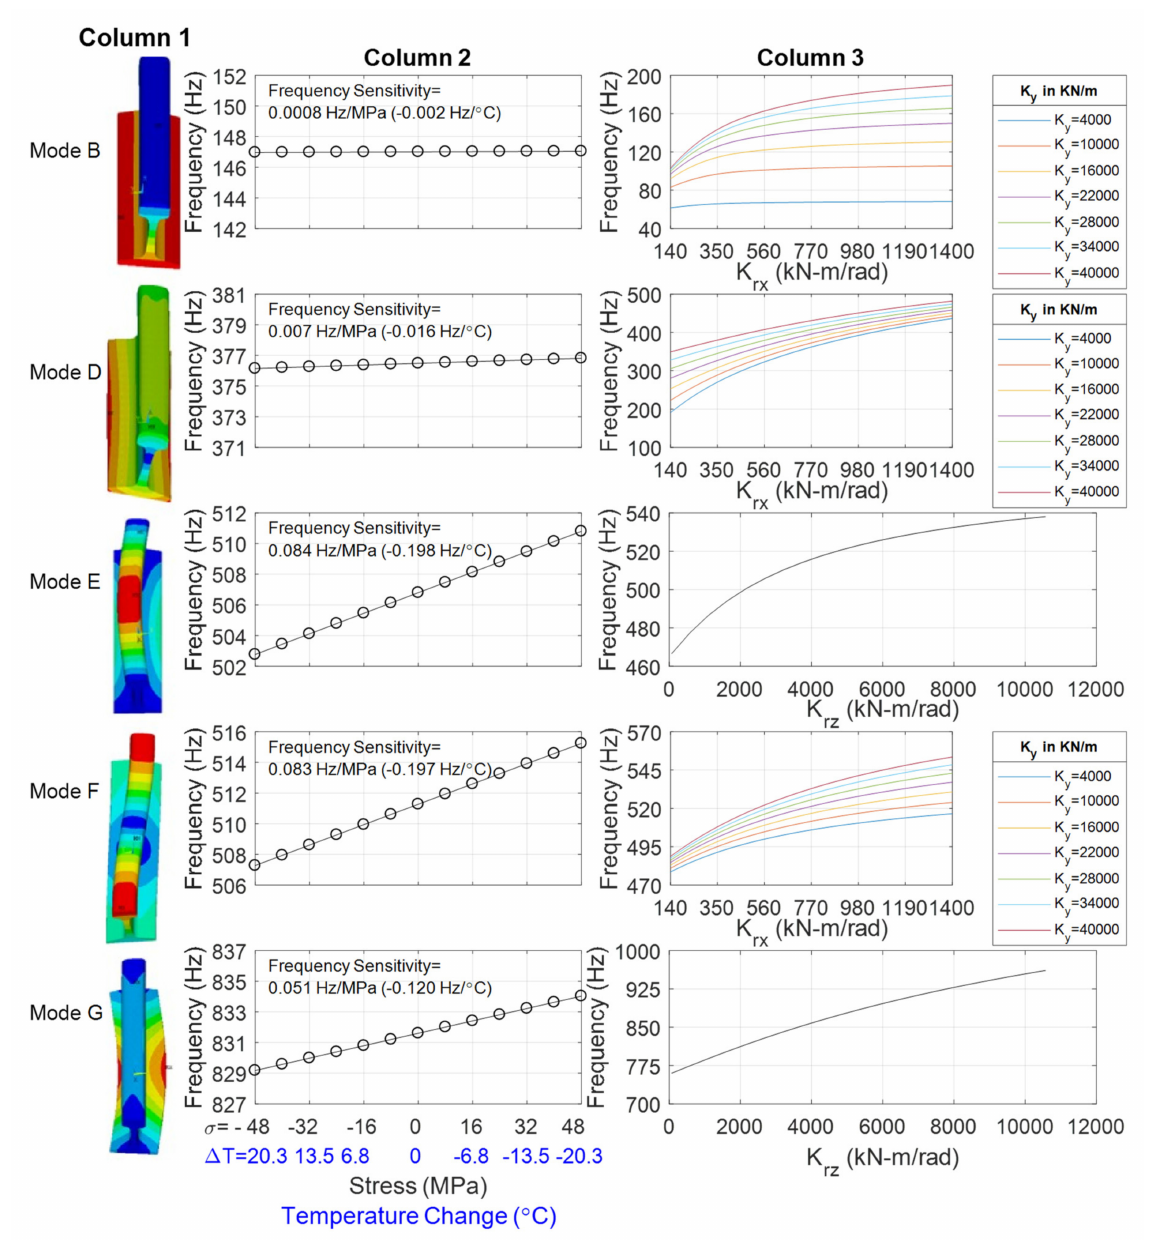
Figure 4. Finite element modeling of a RE 141 tangent track on concrete ties. Left column: mode shape of the lowest five modes. Center column: frequency as a function of stress and temperature change (with respect to the RNT) at given boundary condition. Right column: frequency as a function of certain boundary conditions at neutral